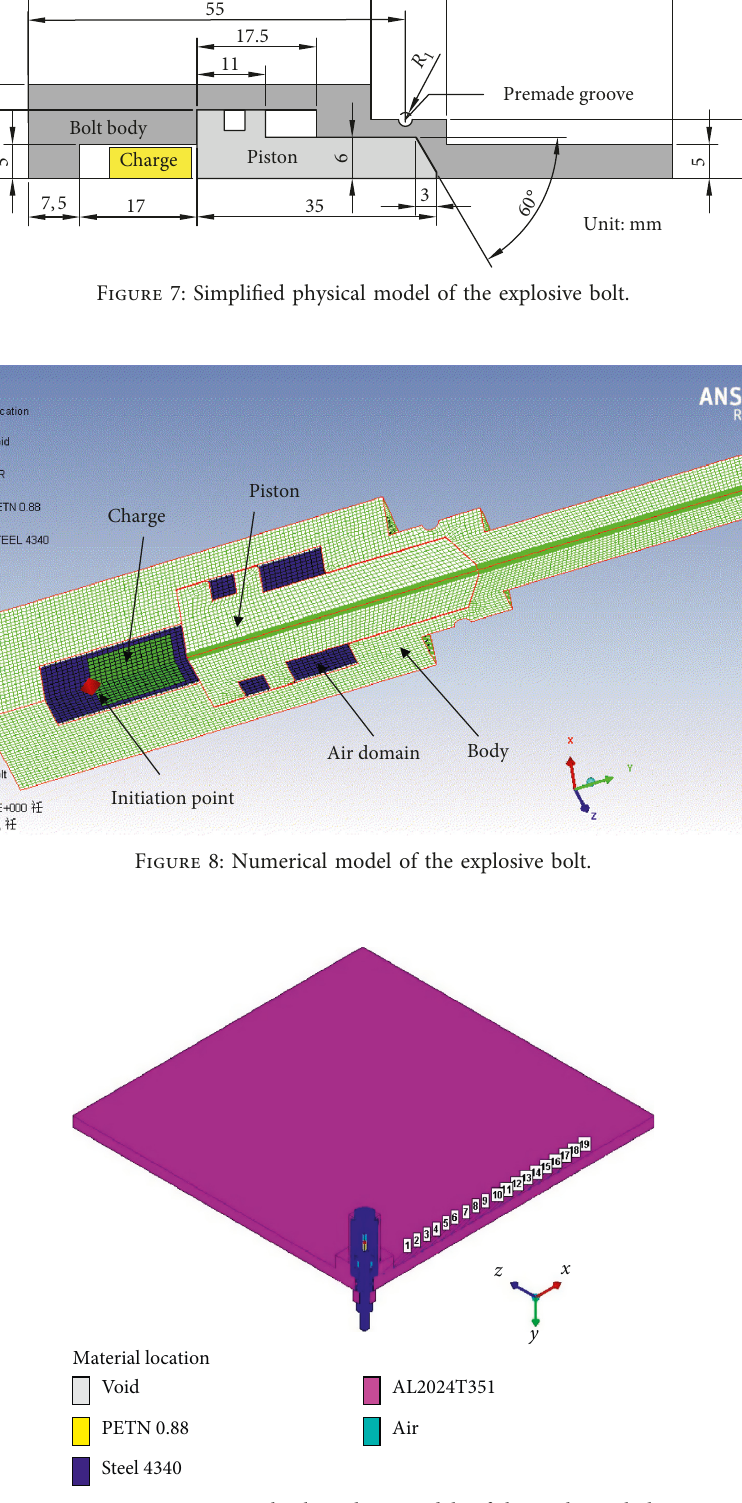
Figure 9: Separation shock analysis models of the explosive bolt.